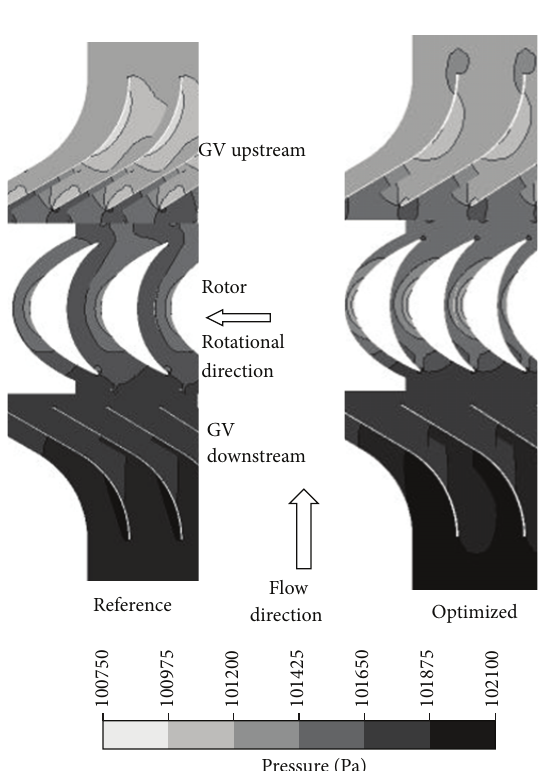
Figure 9: Pressure